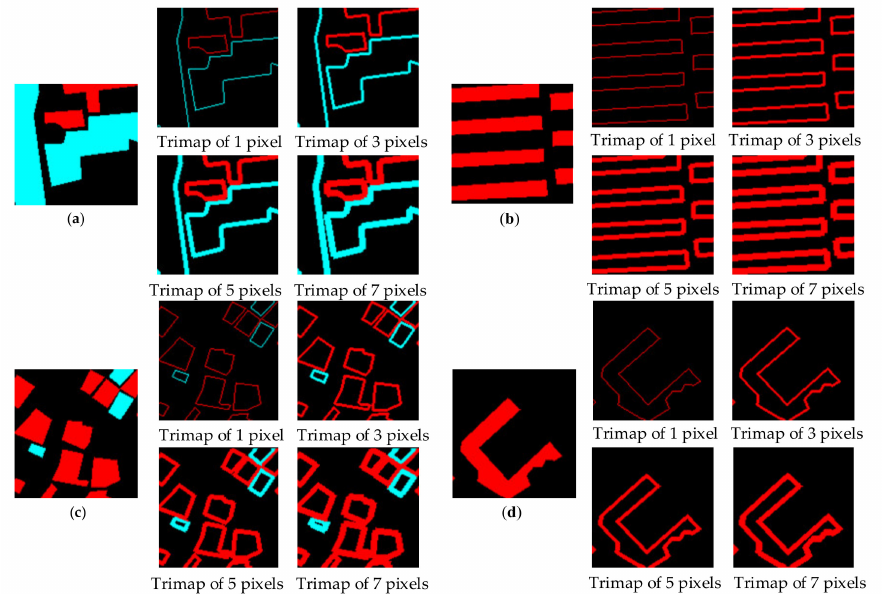
Figure 14. Instance of trimaps with different widths. ( a , b ) are two samples of the YSH dataset; ( c , d ) are two samples of the HTI dataset.